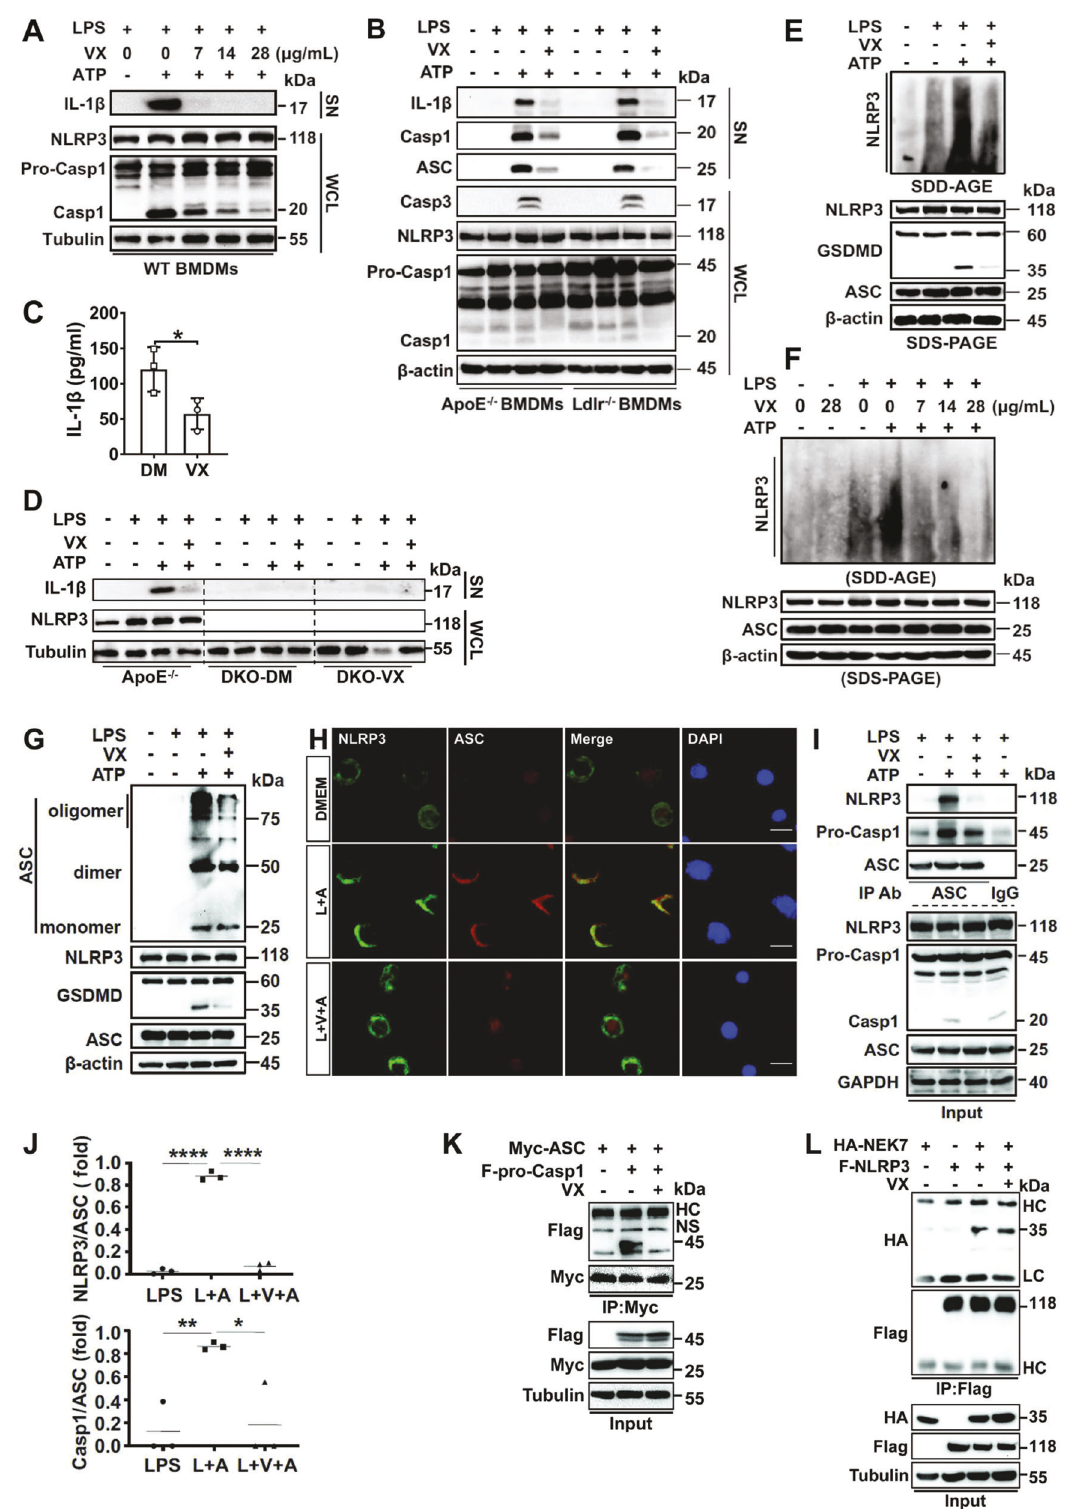
ribosomal RNA. The following primers were used: cytochrome c oxidase I forward, 5 ′ -GCCCCAGATATAGCATTCCC-3 ′ , and reverse, 5 ′ -GTTCATCCTGT TCCTGCTCC-3 ′ ; and 18S rDNA forward, 5 ′ -TAGAGGGACAAGTGGCGTTC-3 ′ , and reverse, 5 ′ -CGCTGAGCCAGTCAGTGT-3 ′ . The copy number of mtDNA was normalized to that of nuclear